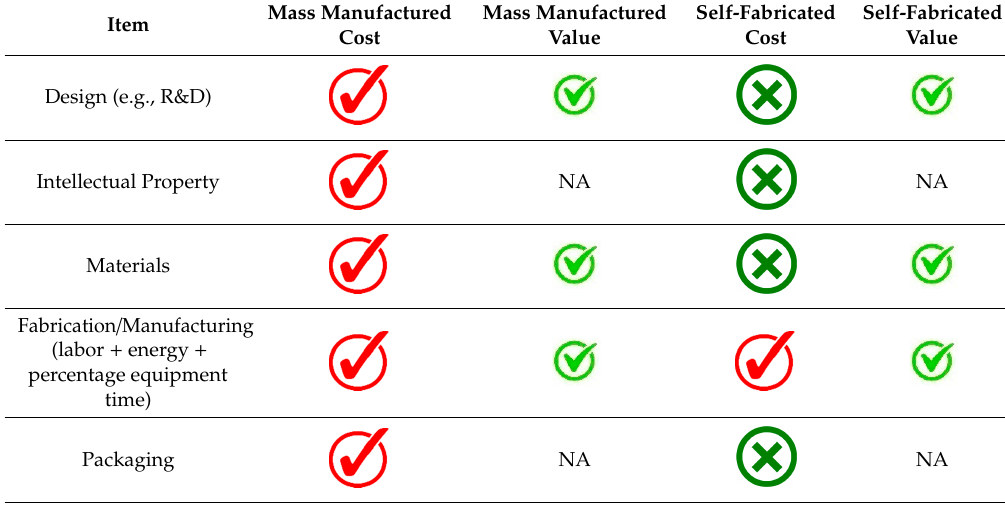
Table 5. The costs and values for a teaching aid from the teacher’s perspective (a red symbol indicates a disadvantage for the teacher/consumer while a green symbol indicates an advantage).